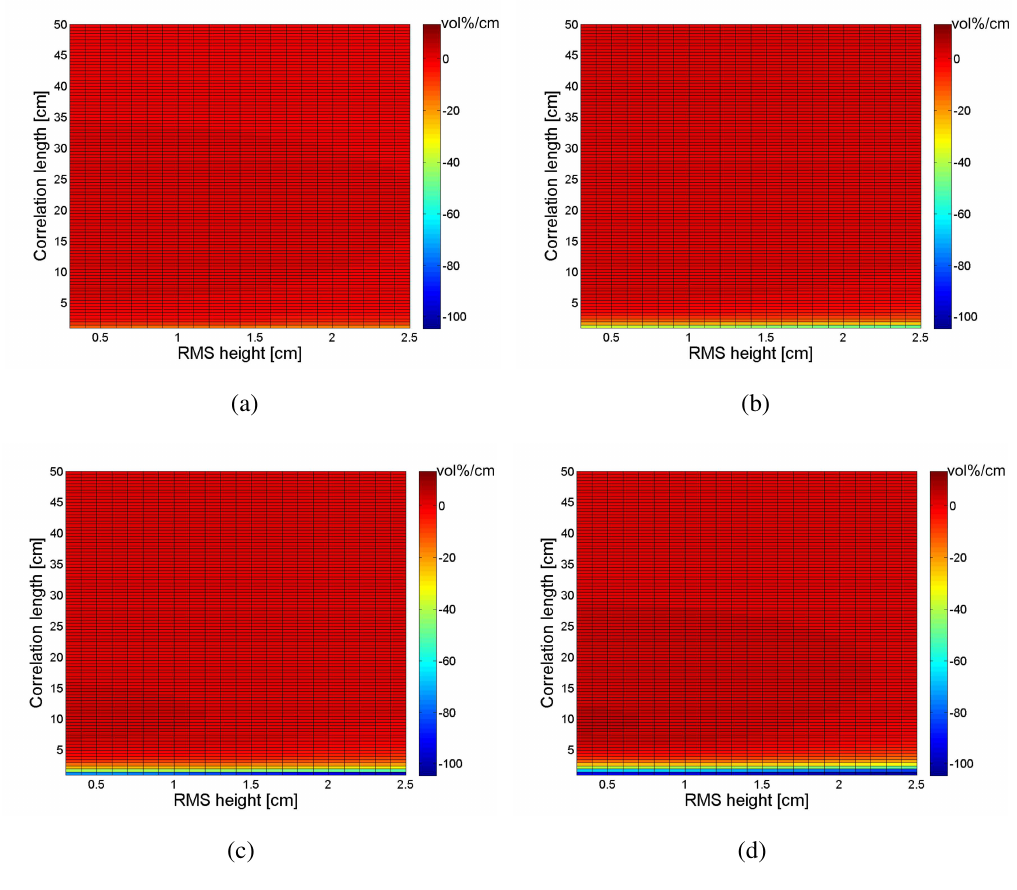
Figure 5. Sensitivity of the soil moisture retrieval to correlation length (vol%/cm) for a PALSAR HH configuration and a moisture content of (a) 5 vol%, (b) 15 vol%, (c) 25 vol%, and (d) 35